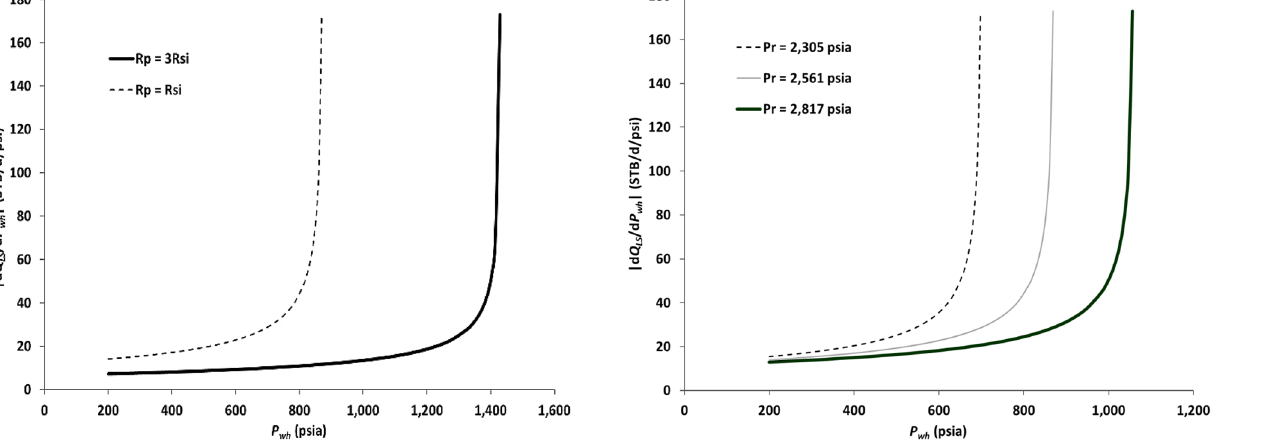
Fig. 12 Stability plots for well A at 30% water cut, but different active GOR